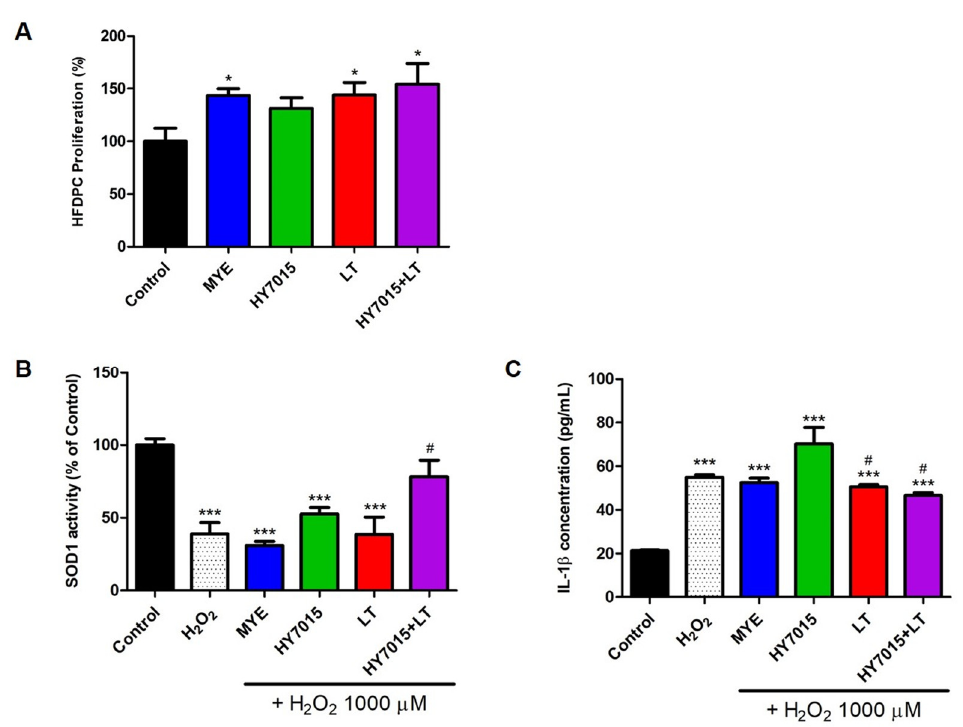
Figure 2. Cytoprotective effects of Lactobacillus paracasei HY7015 (HY7015) and/or Lycopus lucidus Turcz. (LT) extract in HFDPC. Effect of Lactobacillus paracasei HY7015 (HY7015) and/or Lycopus lucidus Turcz. (LT) extract on HFDPC proliferation ( A ). HFDPC were untreated (Control), or treated with medicinal yeast extract (MYE, 50 µg/mL), or with HY7015 (1 × 10 6 CFU/mL) and/or LT (50 µg/mL) for 24 h. SOD1 activity ( B ) and IL-1β ( C ) were measured by ELISA kit. Data are presented as mean ± SE. Significant differences are indicated by * p < 0.05 and *** p < 0.001, relative to the control group. # p < 0.05 compared with H 2 O 2 group. SE, standard error; MYE, medicinal yeast extract; HY7015, Lactobacillus paracasei HY7015; LT, Lycopus lucidus Turcz.; HY7015+LT, Lactobacillus paracasei HY7015 with Lycopus lucidus Turcz.